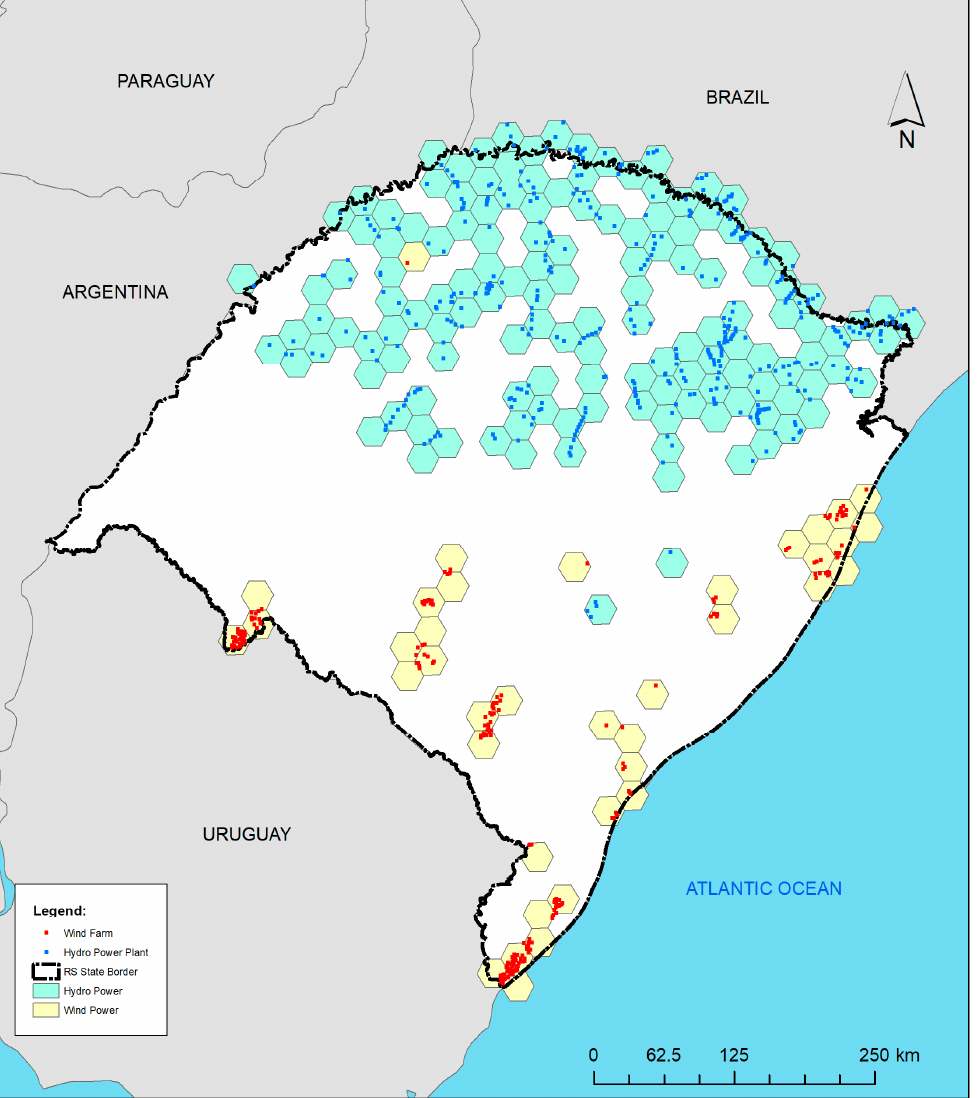
Figure 7. Network with 582 hexagonal cells of 500 km 2 each, for analysis of spatial complementarity in the time along the State of Rio Grande do Sul, indicating hydroelectric power plants and wind farms that are considered in the analysis.